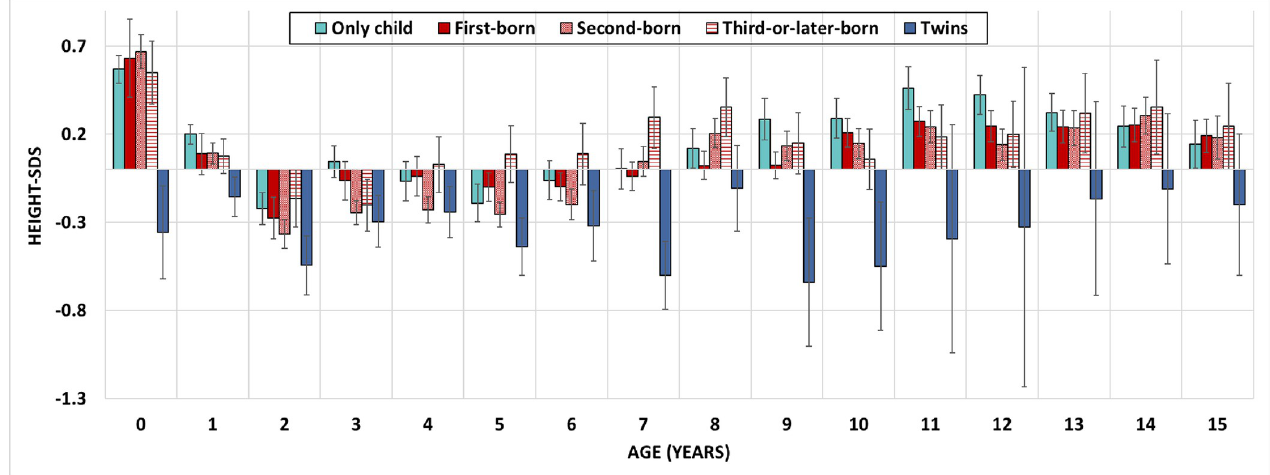
Fig 3. Height-SDS by age and sibling status. Height standard deviation scores in 1-yearintervals are shown according to sibling status: first-born, second- born, third-or-later-born, twins and only children. The values are means with a vertical error indicator (standard error of the mean).